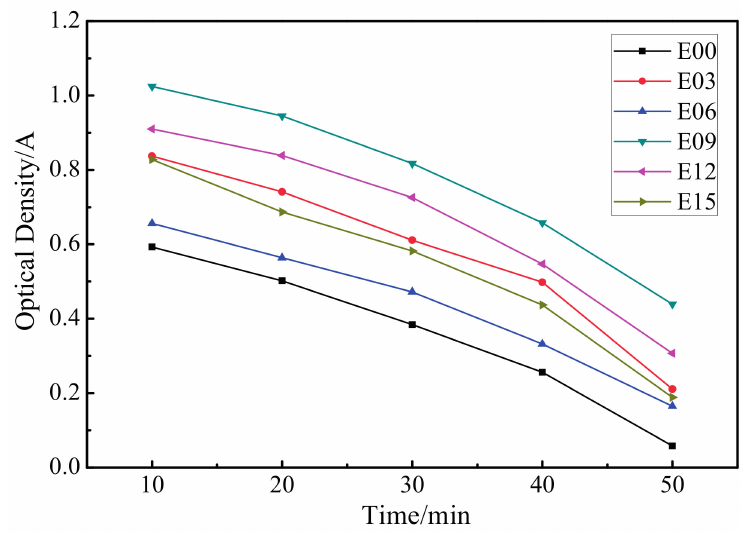
Figure 11. Blood coagulation profiles of samples. E00: substrate; E03: 3 min; E06: 6 min; E09: 9 min; E12: 12 min; and E15: 15 min.